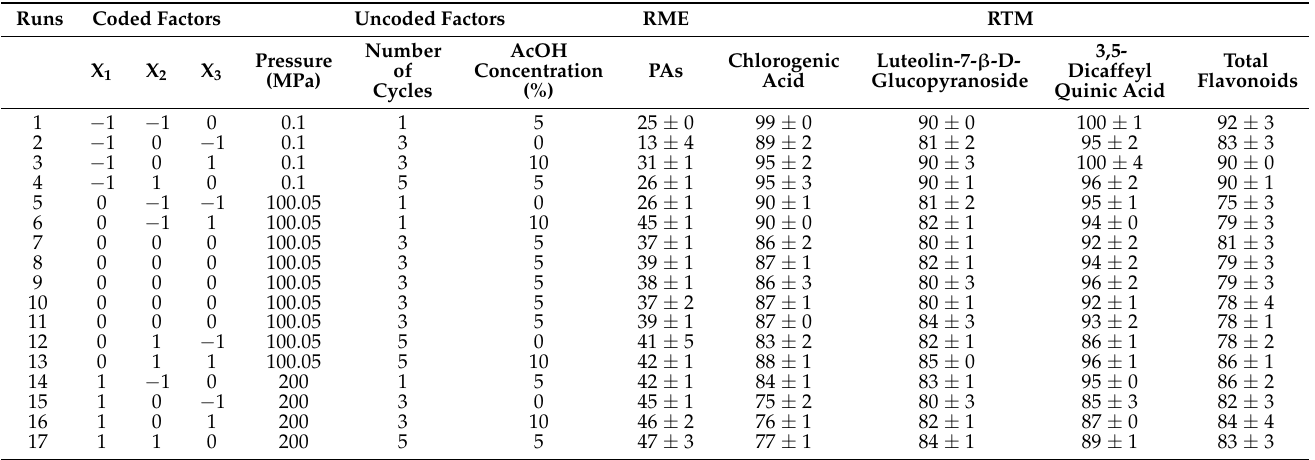
Table 1. Experimental design matrix of HPE conditions and results for PAs’ RME and functional components’